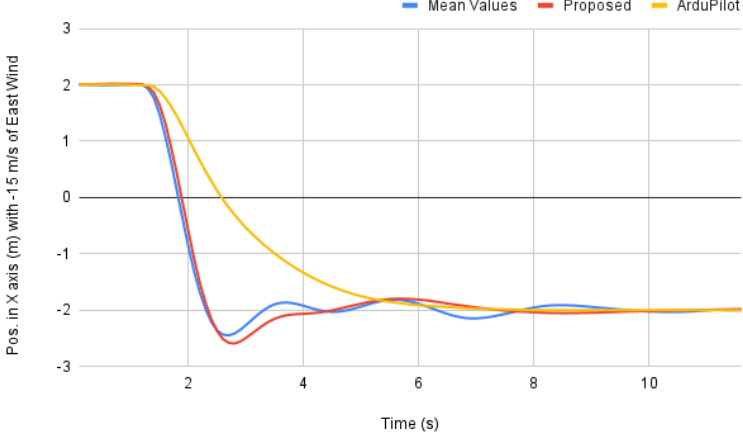
Figure 15. Comparison among different methods in the presence of 15 m/s wind to the